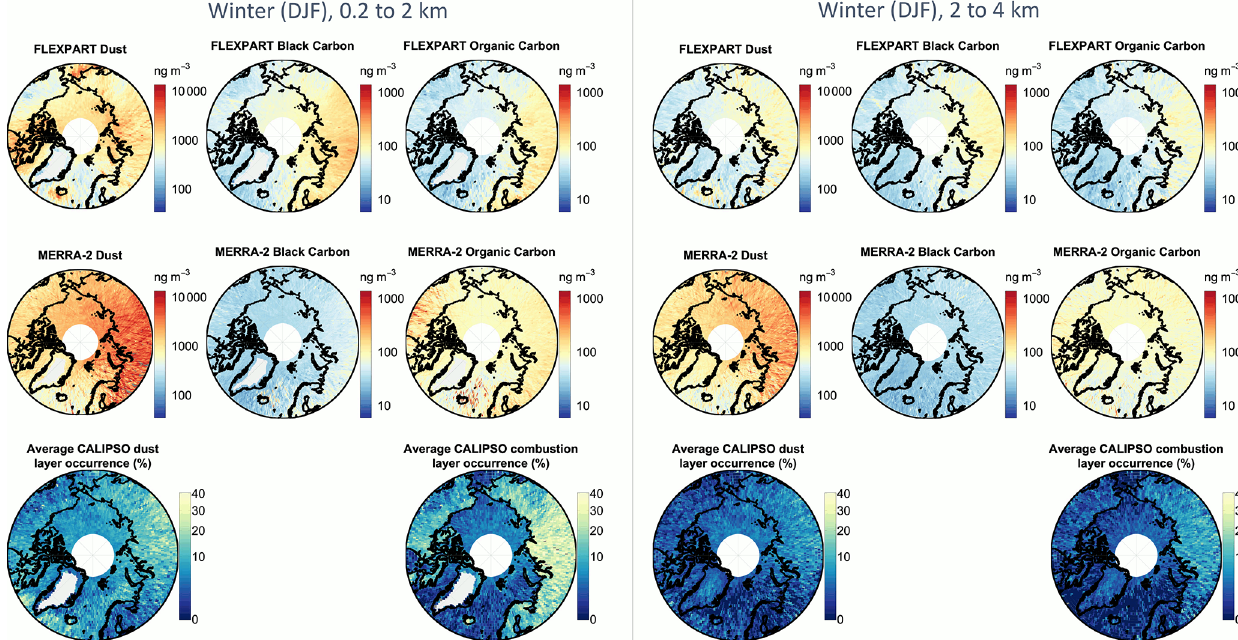
Figure 1. The percent of the time that CALIPSO dust and combustion aerosols occur in wintertime cloud-free profiles below 4km at two different altitude levels and the corresponding distributions of MERRA-2 and FLEXPART submicron mineral dust, black carbon, and organic carbon. There is agreement that dust (an efficient source of ice-nucleating particles) is high over Siberia. Data at higher altitudes are shown in Fig.